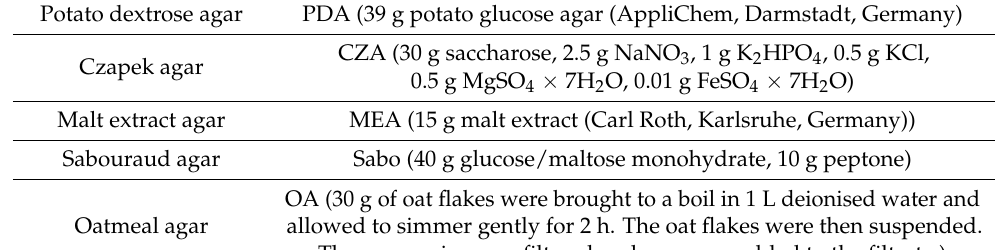
Table A1. Culture media used for macroscopic characterisation. The media were all prepared with distilled water and subsequently sterilised by autoclaving at 121 ◦ C and 1 bar for 30 min. The following quantities refer to a final volume of 1 L. For solid media, if not described otherwise, 1.5% agar ( w / v ) was